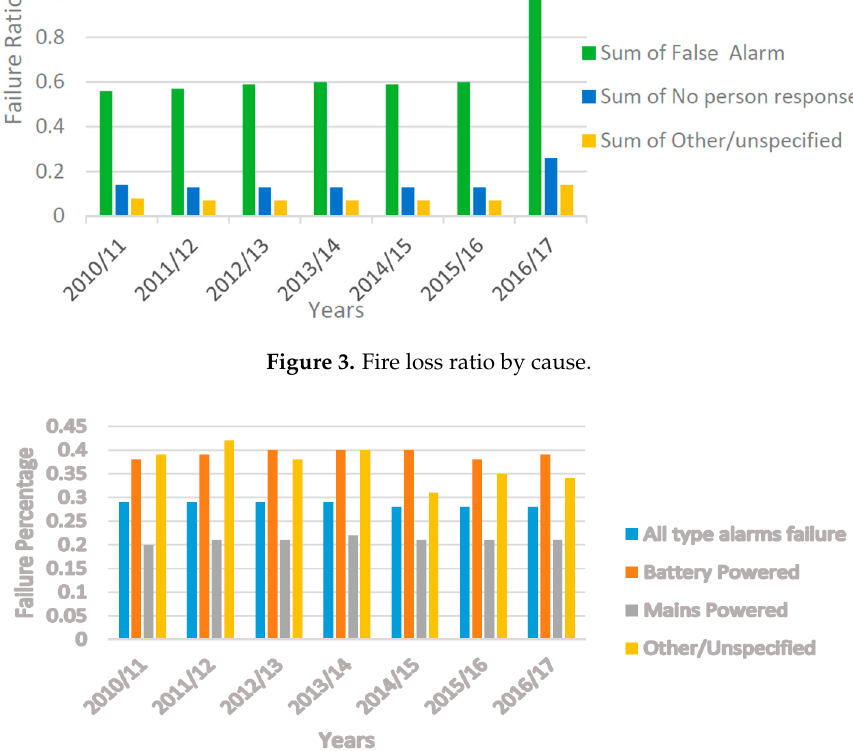
Figure 3. Fire loss ratio by cause.